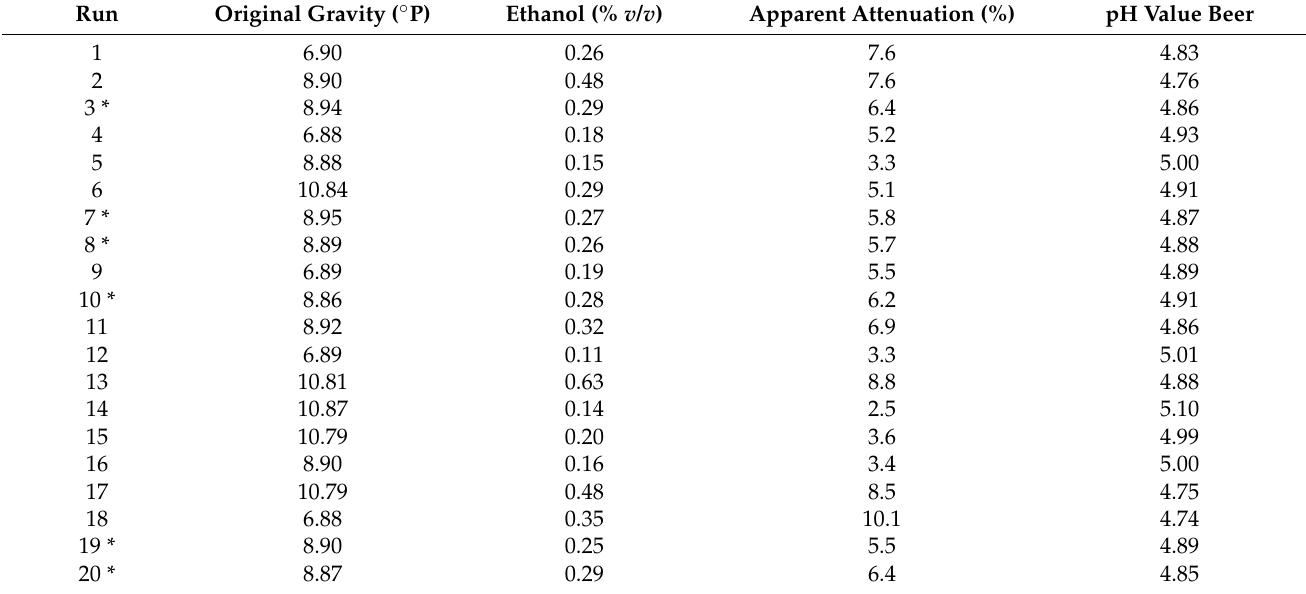
Table 4. Analyzed values of original gravity ( ◦ P), ethanol (% v / v ), apparent attenuation (%), and pH value in the 20 beers fermented with parameters of the response surface methodology (RSM)